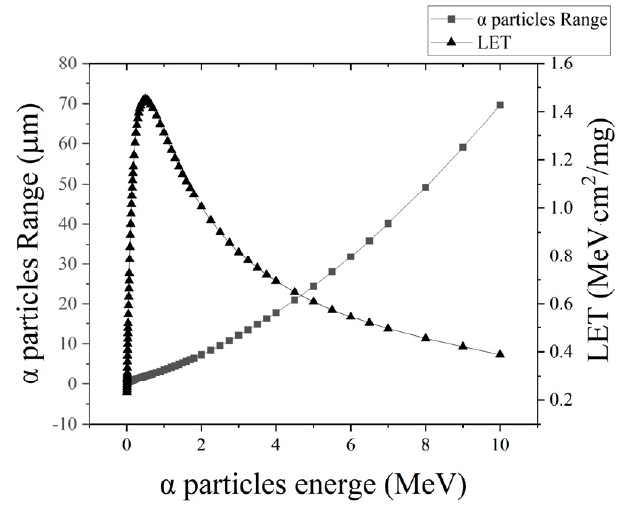
Figure 4. The LET and range of α particles in silicon varies with energy. emitted isotropically at a rate of 2 π from the surface of a cylindrical source with a thickness of 1 mm and a diameter of 45 mm. It has an emissivity of 1.21 × 10 6 particles/2 π · minute, which is much higher than the alpha particle emissivity in the real environment. All these parametric conditions are in accordance with international standards, i.e., JESD89 A [23], so it is suitable to be used for the accelerated testing of soft error rates introduced by alpha particles. In this experiment, the chip under test must have the packaging material removed from its surface to ensure that the particles are able to reach the sensitive areas inside the